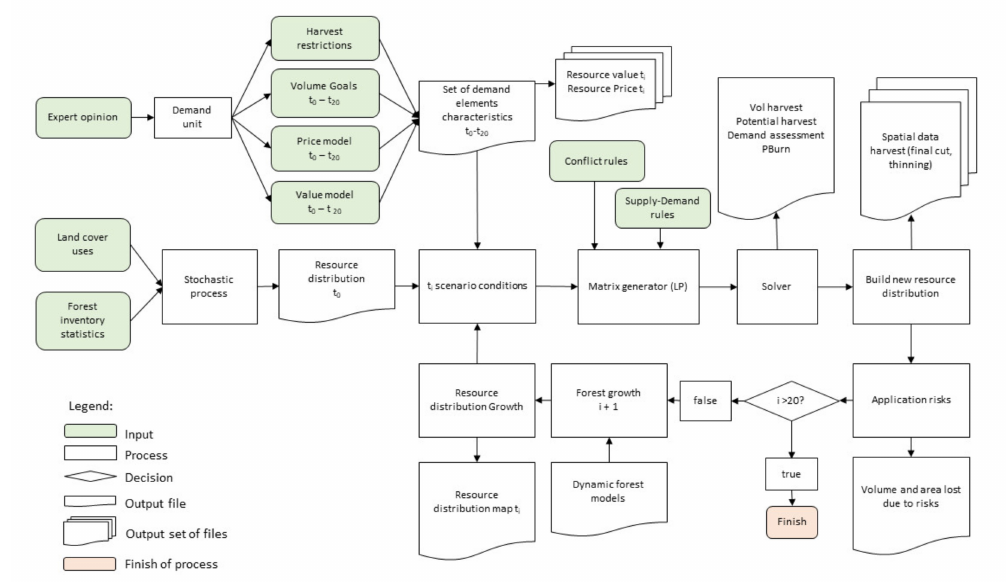
Figure 2. Flow diagram of the simulation procedure applied in for supply, demand, and supply–demand interactions assessment. AppTitude ® implements quantity, value and price models to define scenario conditions required for the linear programming matrix that is iterated and solved annually for a 20-y period applying forest growth models in the area of